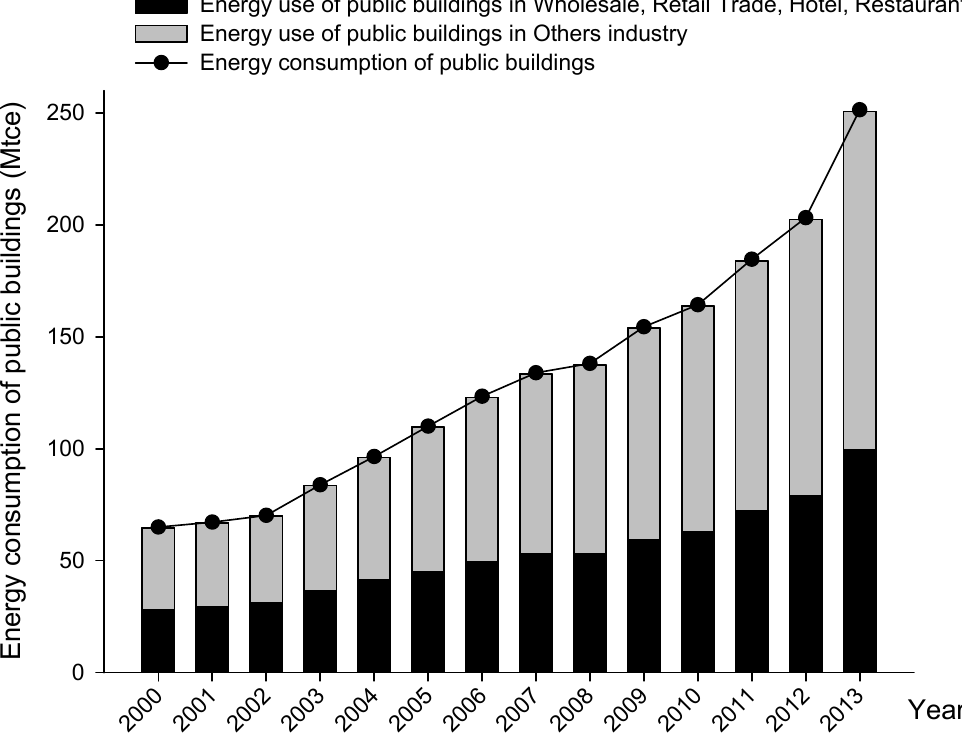
Figure 5. The energy consumption of public buildings in China during